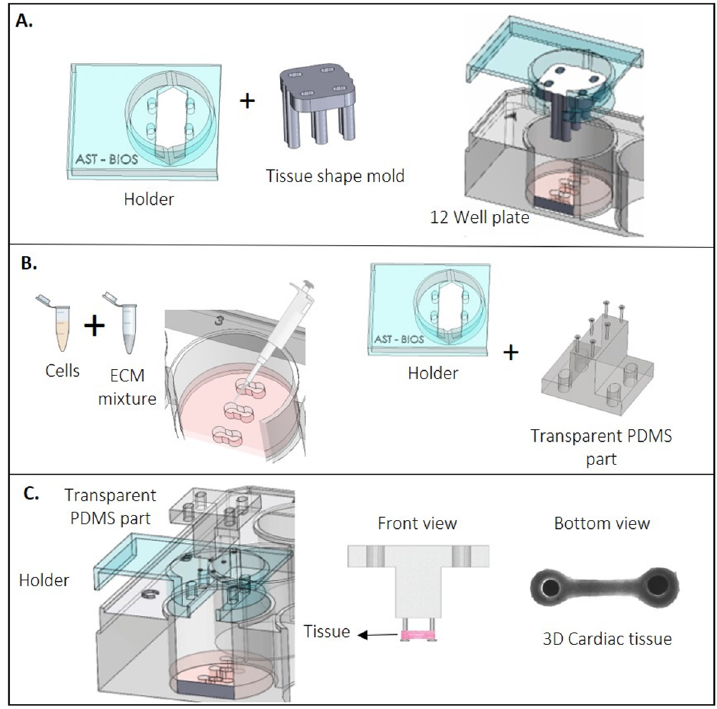
Figure 3. Process of making the EHTs. ( A ) Strip format using a Teflon spacer into a well. ( B ) Diagram of adding the cell suspension with a fibrinogen-based ECM into each tissue slot of a well. ( C ) Schematic of the EHT fabrication.